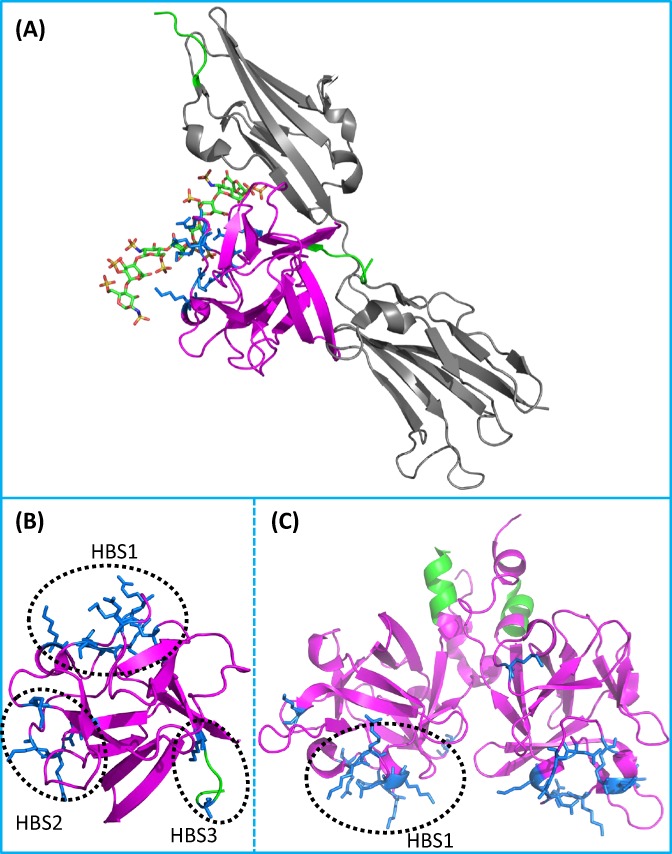
FGF interactions with FGFR and heparin/heparan sulfate.(A) Ternary structure of FGF-FGFR-heparin complex (1FQ9 (Schlessinger et al., 2000)). FGFs interact with the D2 and D3 domain and the linker between these two domains. A heparin octasaccharide, binds to the conserved canonical binding site on FGFs, which is opposite to the N-terminal, and to the basic canyon in the FGFR. (B) Heparin binding sites of FGF2 (1FQ9) identified by a selective labelling approach (Ori et al., 2009). Three binding sites were recognised: the canonical binding site (HBS1), and two secondary and relatively weaker binding sites (HBS2 and HBS3). (C) Heparin binding site of FGF9 (1G82 (Hecht et al., 2001)). Only the conserved HBS1 was identified, indicating that FGF9 does not possess secondary polysaccharide binding sites (Xu et al., 2012), subsequently confirmed in biophysical experiments (Migliorini et al., 2015). Green indicates the N-terminal of the proteins. Grey is FGFR1. Magenta are FGFs (FGF2 in B and FGF9 in C). The residues in blue are the heparin binding sites of the FGFs.